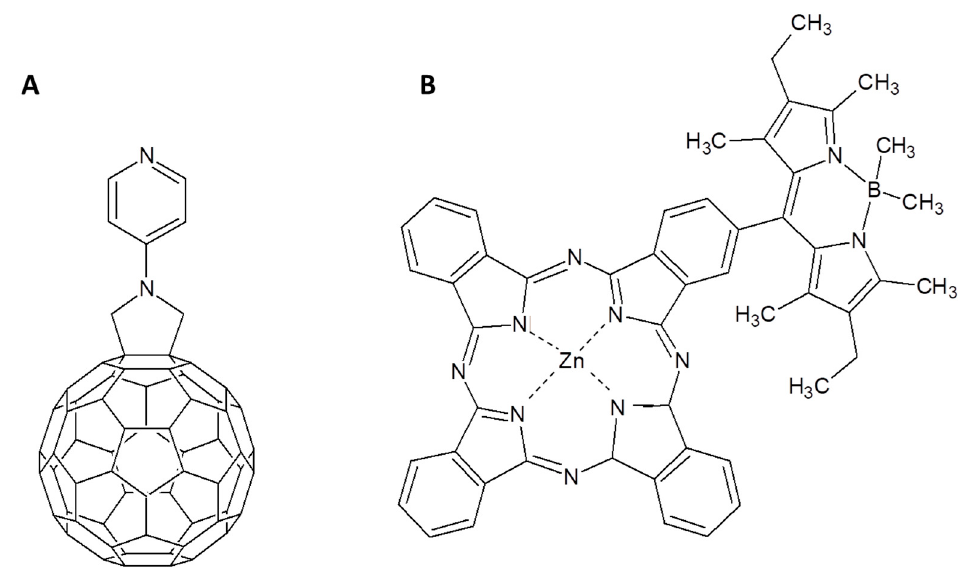
Figure 13. ( A ) Pyridine functionalized fulleropyrrolidine and ( B ) BODIPY-substituted ZnPc proposed in [92].